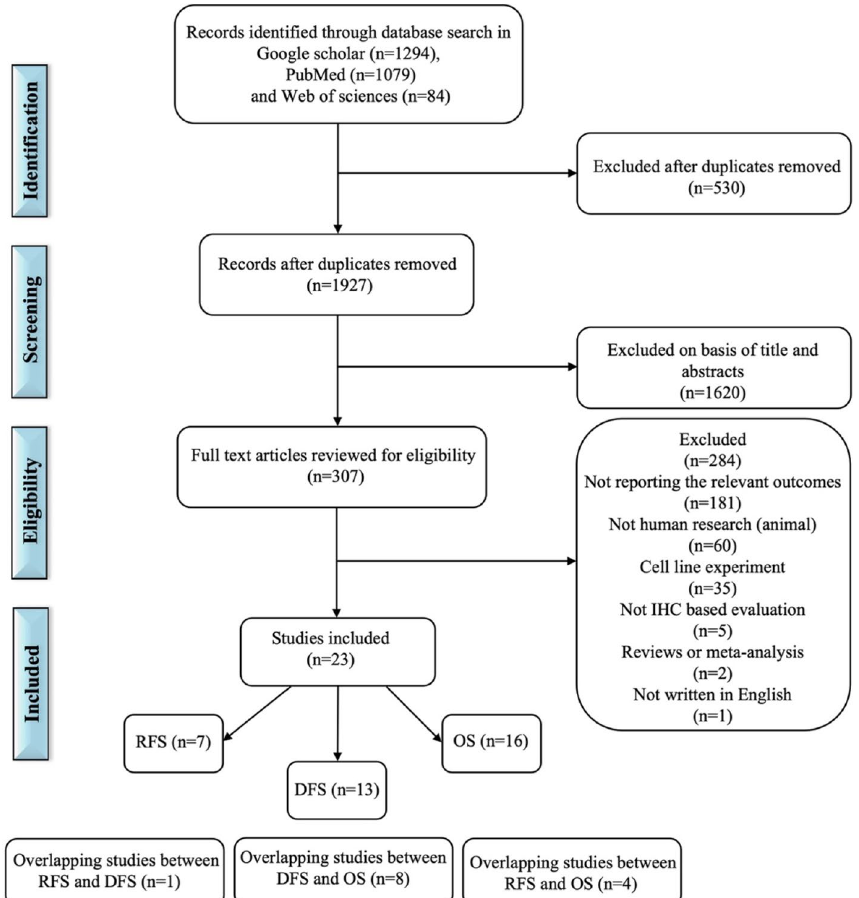
Fig. 1 Flow chart of selecting articles describing the association between CAIX expression and patient’s